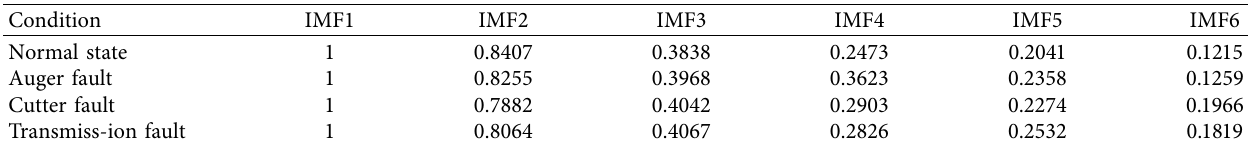
Table 4: Correlation